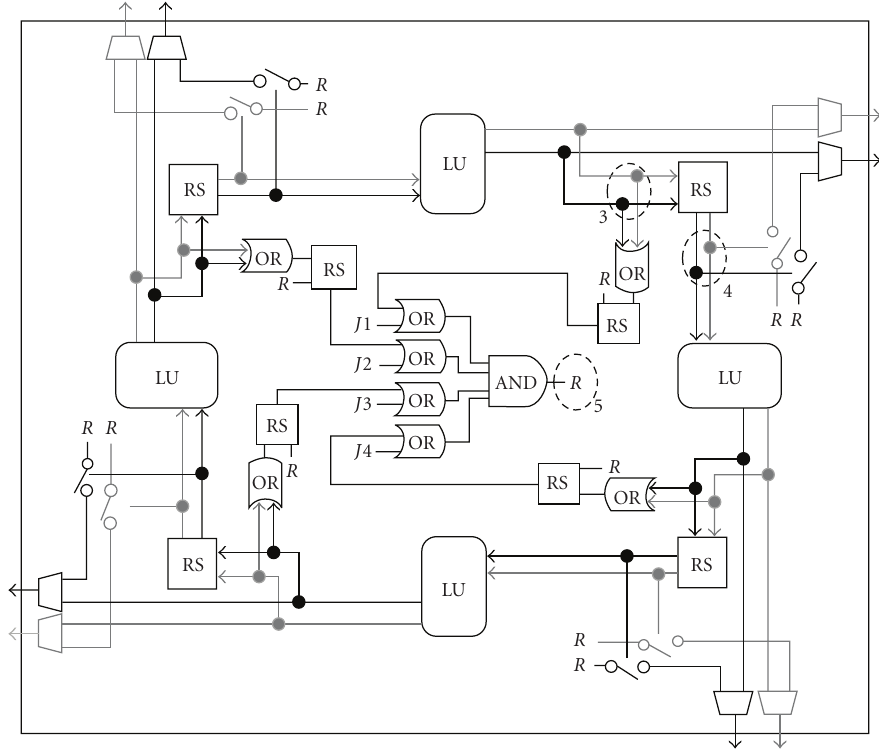
Figure 6: PQ-cell circuitry involved in performing the join operation.